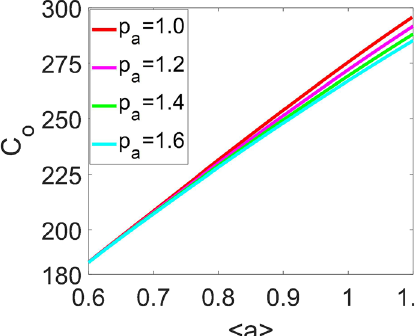
Fig. 18 Variations in the coherence versus the average value of the scale factor (cid:7) a (cid:2) . The horizontal and vertical axes represent (cid:7) a (cid:2) and coherence, respectively. The parameters are taken as: α = 1, V 0 = π (cid:14) a = (α 2 / 2 + 8 π 2 t 2 / 9 V 2 α 2 ) 1 / 2 , respectively. Both (cid:7) a (cid:2) N 0